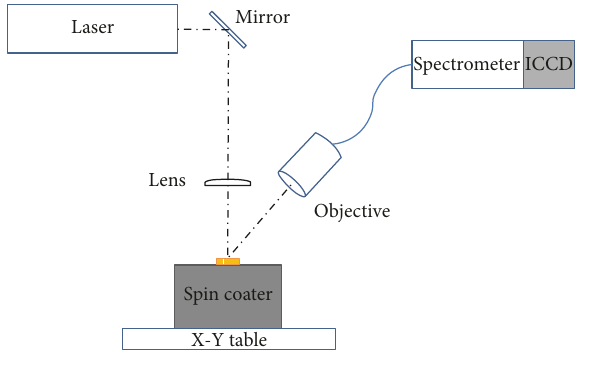
Figure 1: Experimental